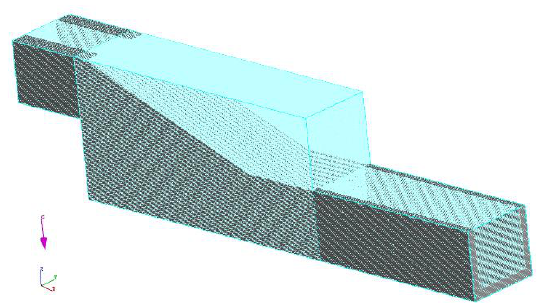
Figure 1. Meshing pattern in the computational domain.